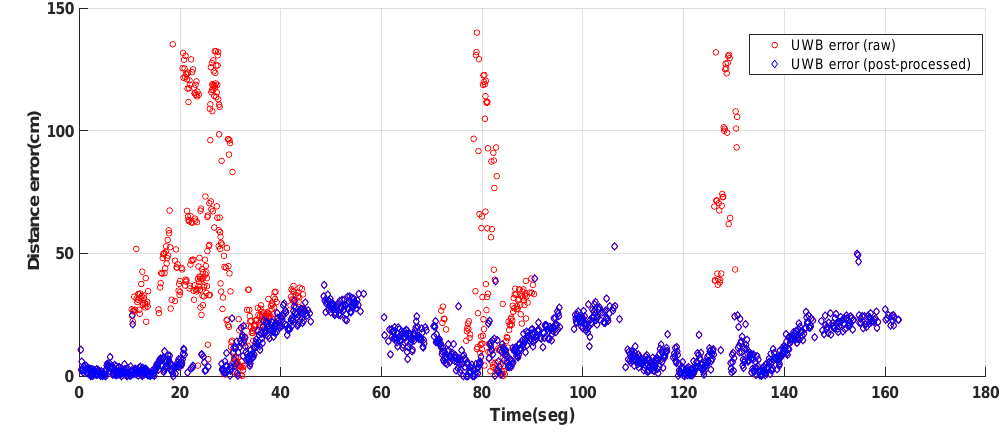
Figure 11. Distance error of the UWB ranging